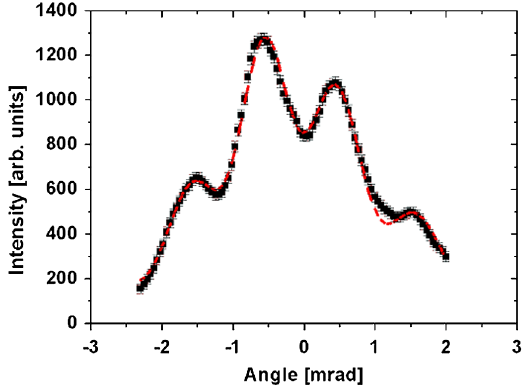
FIG. 12. ODRI angular distribution of a beam going through a slit displaced by 50 (cid:3) m with respect to the former case. Both experimental data (black squares) and a fit, based on the theo- retical model (red dashed line), are